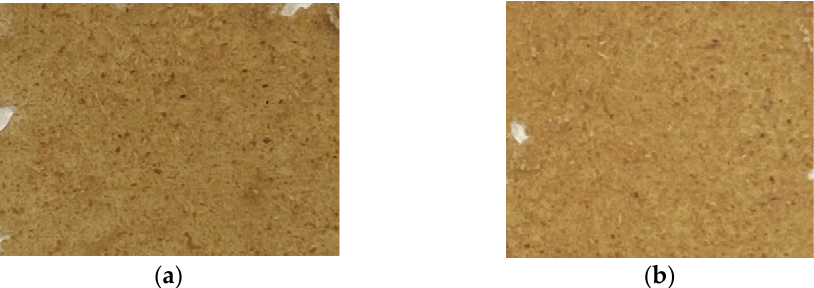
Figure 2. Macroscopic views of hot-pressed films prepared using G 35 (35% glycerol) film-forming mixtures by applying ( a ) 0.42 t and ( b ) 0.84 t pressure levels.